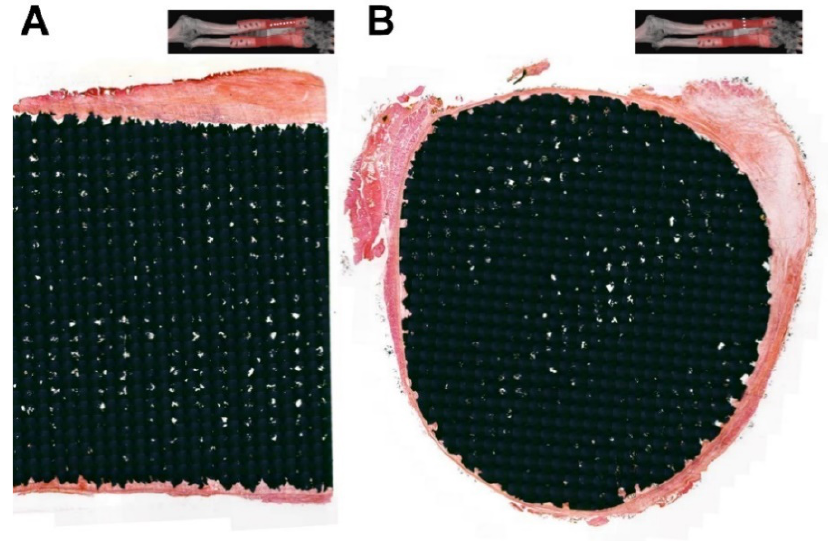
Figure 6. Analyzed sections of the ulnar implant shaft. Photomicrograph (( A , B ): Goldner’s trichrome staining, 1 × magnification) of the histological specimens of the longitudinal and axial sections, with scout images in the upper right corners showing soft tissue adhesion without the uncovered area.